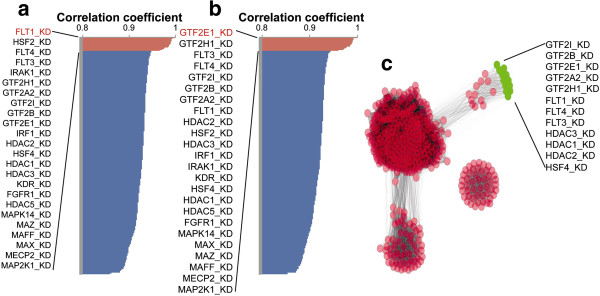
Analysis of a human umbilical vein endothelial cells dataset (GSE 27871) [27] created using siRNA-mediated knockdown of 400 specific signaling molecules and transcription factors. Panel a. Pearson correlation analysis of FLT1 siRNA-mediated knockdown with other datasets revealing a common gene regulatory network of GTF2E1 and FLT1. Panel b. Pearson correlation analysis of GTF2E1 siRNA-mediated knockdown with other datasets revealing a common gene regulatory network of GTF2E1 and FLT1. Panel c. Correlation matrix of all siRNA-mediated knockdowns revealing significant (r > 0.95) gene clusters. The gene cluster connecting GTF2E1 and FLT1 (i.e., GTF-FLT-HDA-HSF gene cluster) is shown in green.